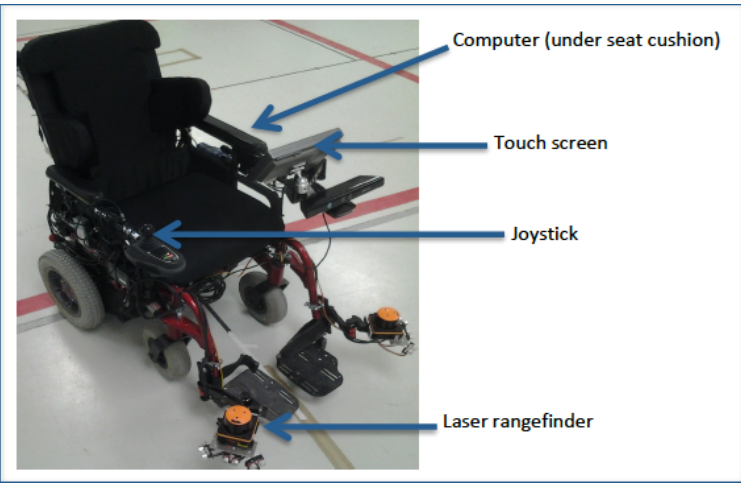
Figure 1. Intelligent power wheelchair prototype.